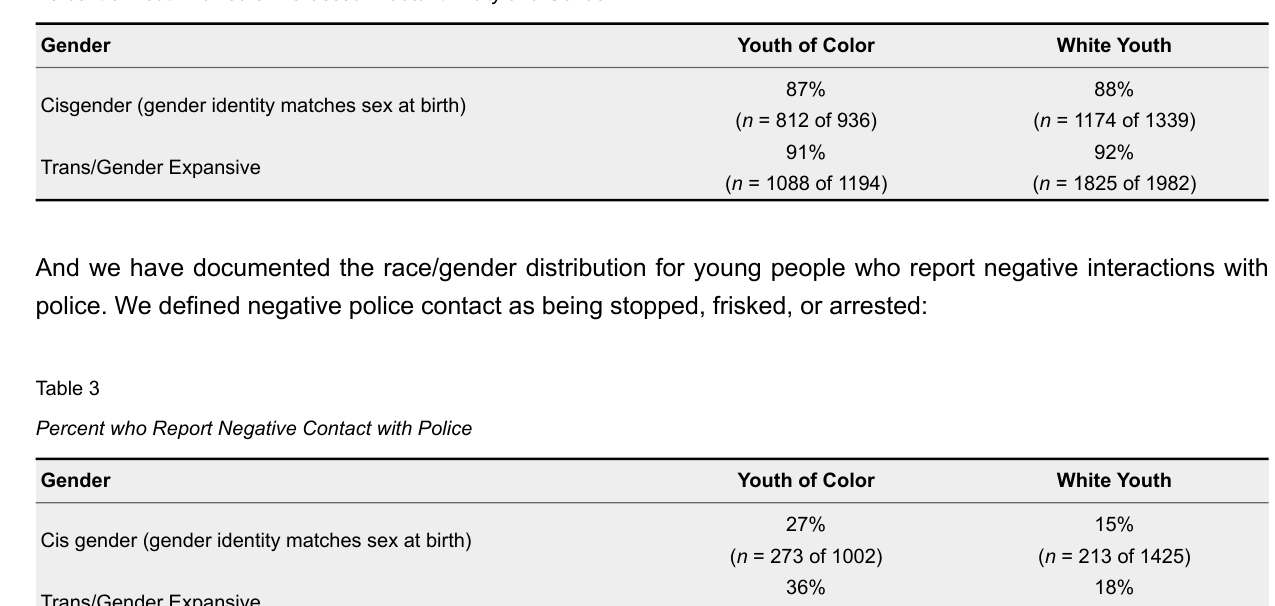
Percent of Youth Bullied or Harassed: Race/Ethnicity and Gender